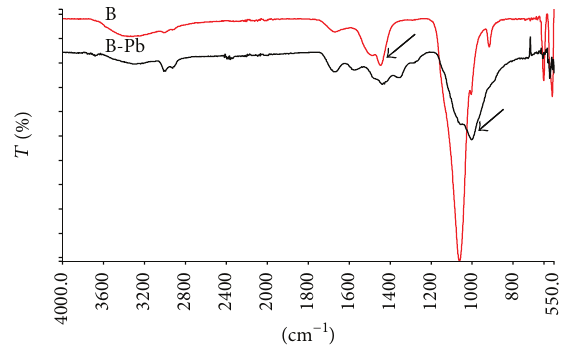
Figure 2: FT-IR spectra of B and